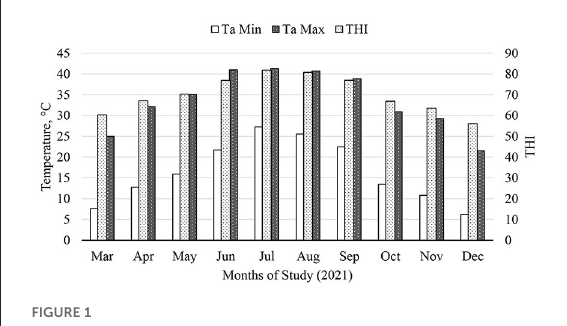
(0.8 Ta) [(H/100) (Ta – 14.4)] = × + ×